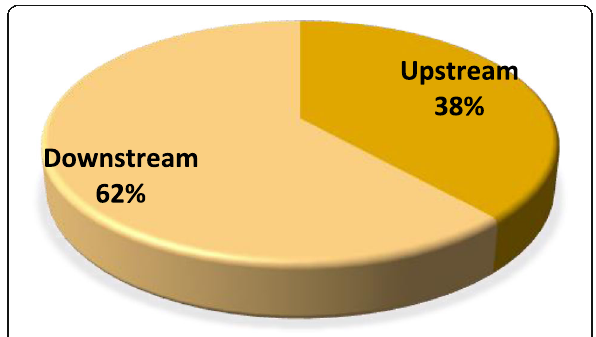
Fig. 2 Percentage of isolated bacteria from two contaminated water samples along Al-Rahawy drain, Giza Governorate,